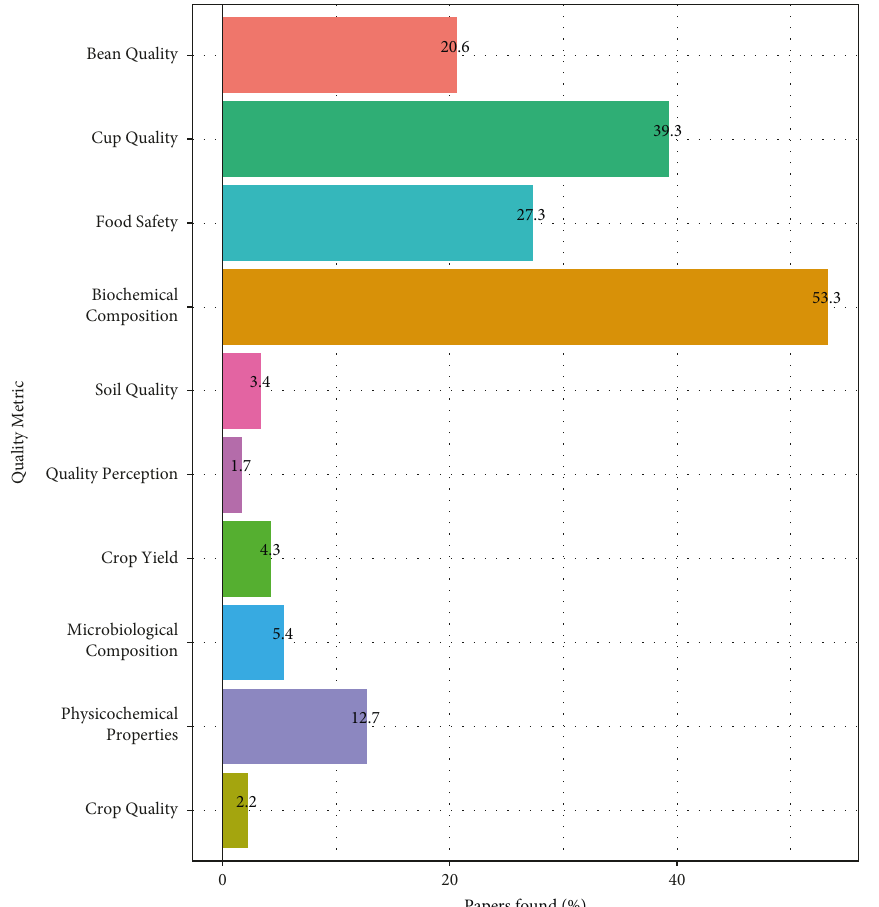
Figure 3: Percentage of the articles classified by coffee quality